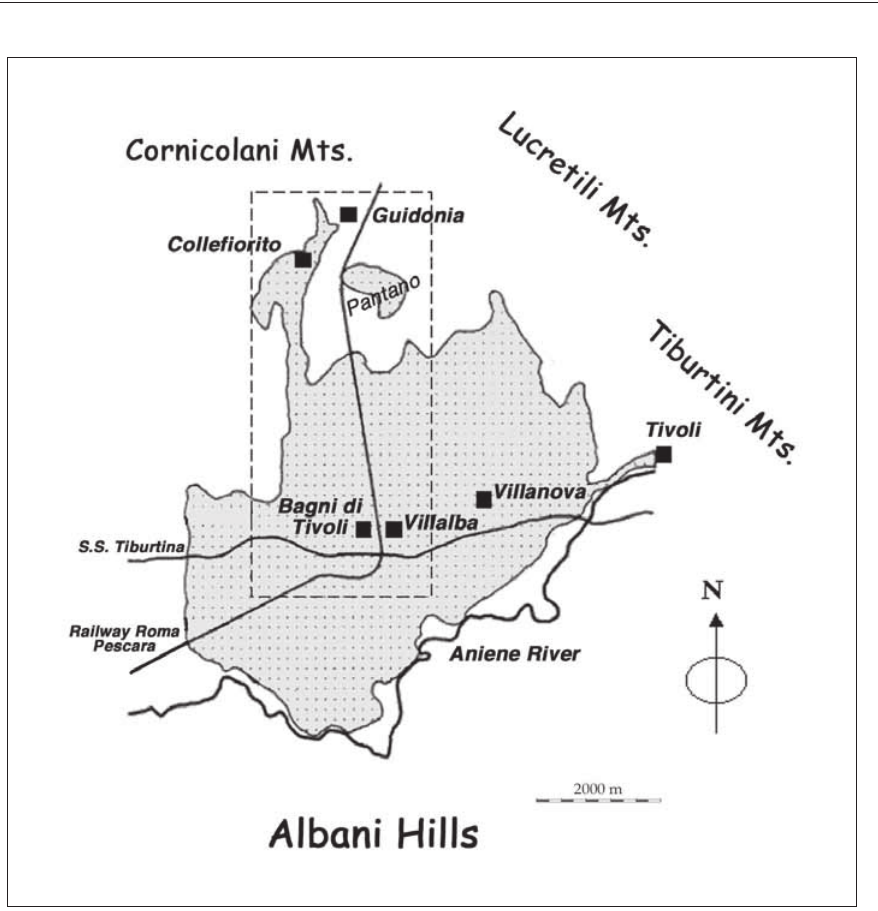
Fig. 2. Sketch map of Acque Albule travertine basin and location of the towns involved in this